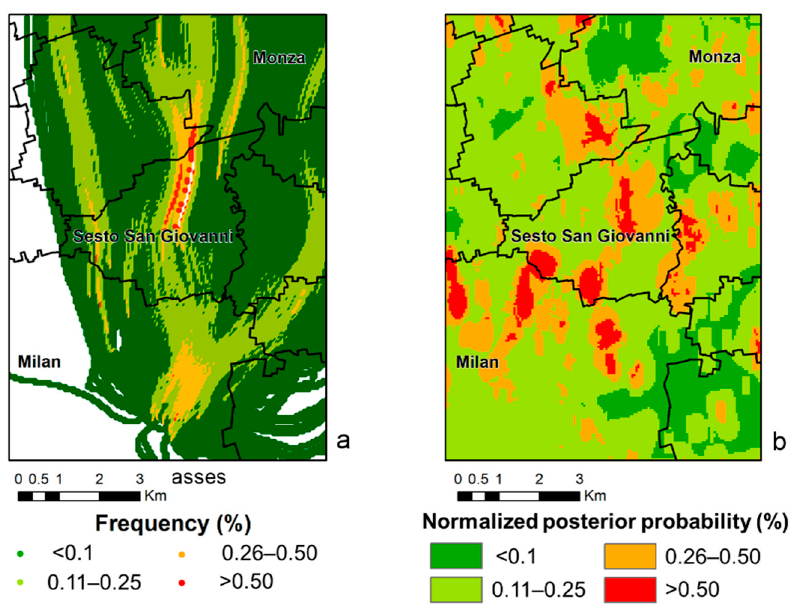
Figure 11. Map ( a ) represents the contributing diffuse contamination areas defined by the occurrence frequency of particles backtracked within the study area. High percentages of frequency express a high probability of finding sources responsible for diffuse PCE contamination (red areas). Map ( b ) shows the distribution of the normalized posterior probability. High percentages of normalized posterior probability correspond to a high degree of susceptibility (red areas).